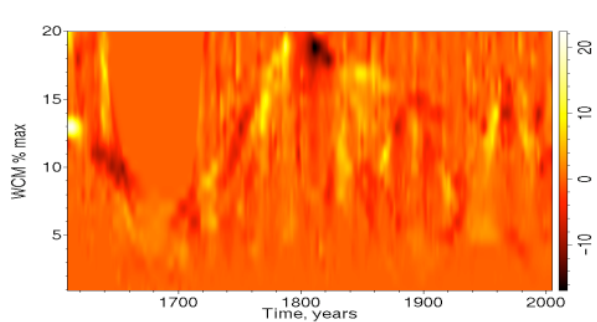
Fig. 9. Ampligram of the group sunspot number 1610–1995 and the sunspot number 1995–2005. In the lower panel only the weak signal, below 20% of WCM maximum, is